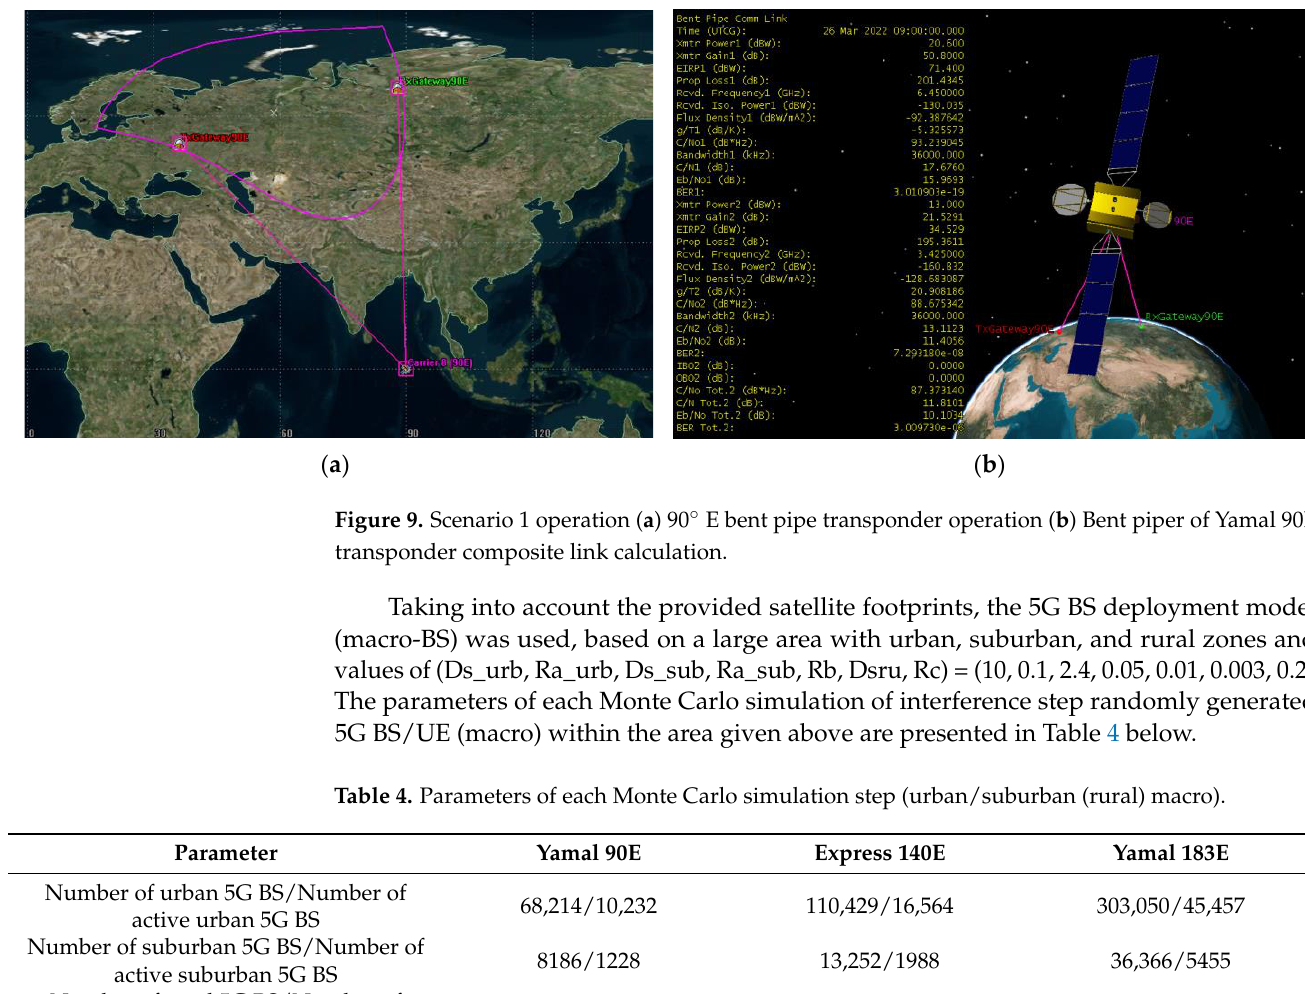
Figure 10. Cumulative distribution function of C/(N+I) for transponder Yama; 183E for 6/4 GHz.